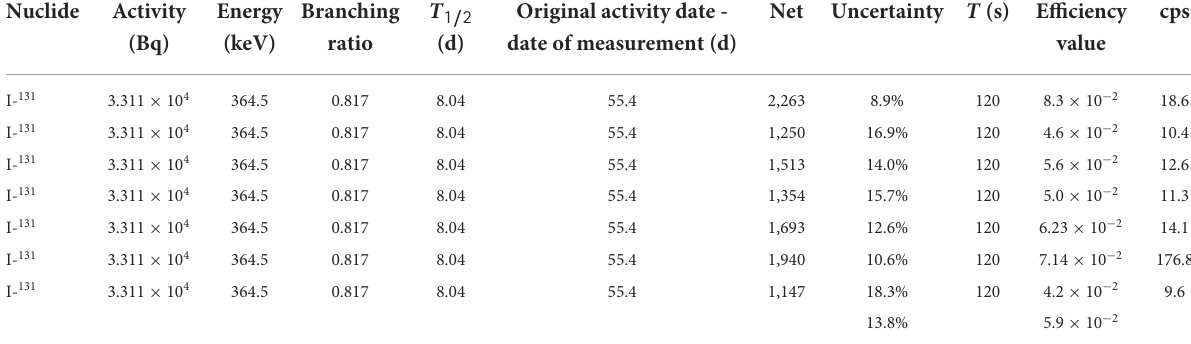
TABLE 2 131 I standard source and percentages of